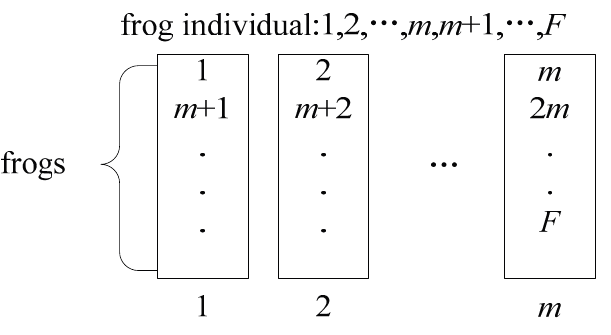
Figure 2. The sub-population division